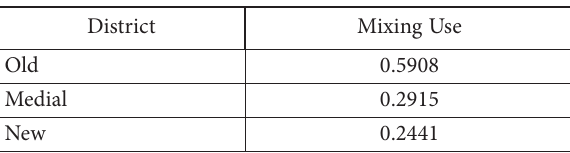
Table 3. The extent of mixed land use in the three districts Table 5. Calculation of the density indexes in the three studied